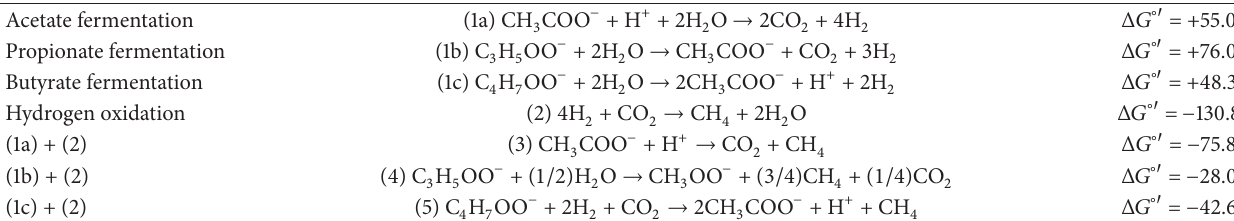
Table 1: Stoichiometry and thermodynamics of syntrophic acetate, propionate, and butyrate